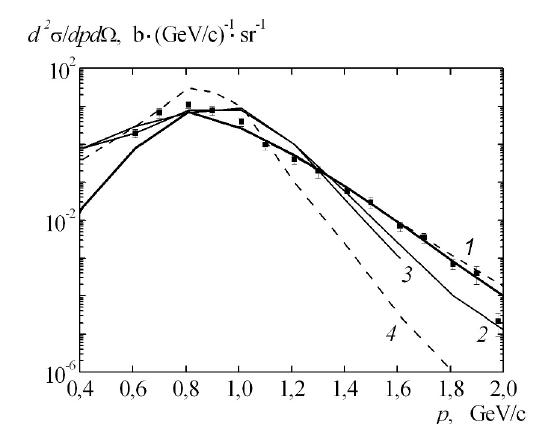
Figure 3. The momentum distributions of protons emitted in the reaction 12 C + 9 Be → p + X at an angle of 3 . 5 o with the 12 C ion energy of 300 MeV / nucleon. Curve 1 is our calculation, the dashed curve 1 is our calculation without taking into account the amendment for the microcanonical distribution, the points are the experimental data from [9]. Curves 2, 3, 4 are results of calculations for transport codes [9]. Curve 2 corresponds to the cascade model [15], curve 3 corresponds to the transport model of quark-gluon strings [16], curve 4 corresponds to the model of quantum molecular dynamics (QMD) built into the GEANT4 package [17]. In this case, < T h > ≈ 33.2 MeV, < µ T > ≈ -2.2 MeV, < R h > ≈ 2